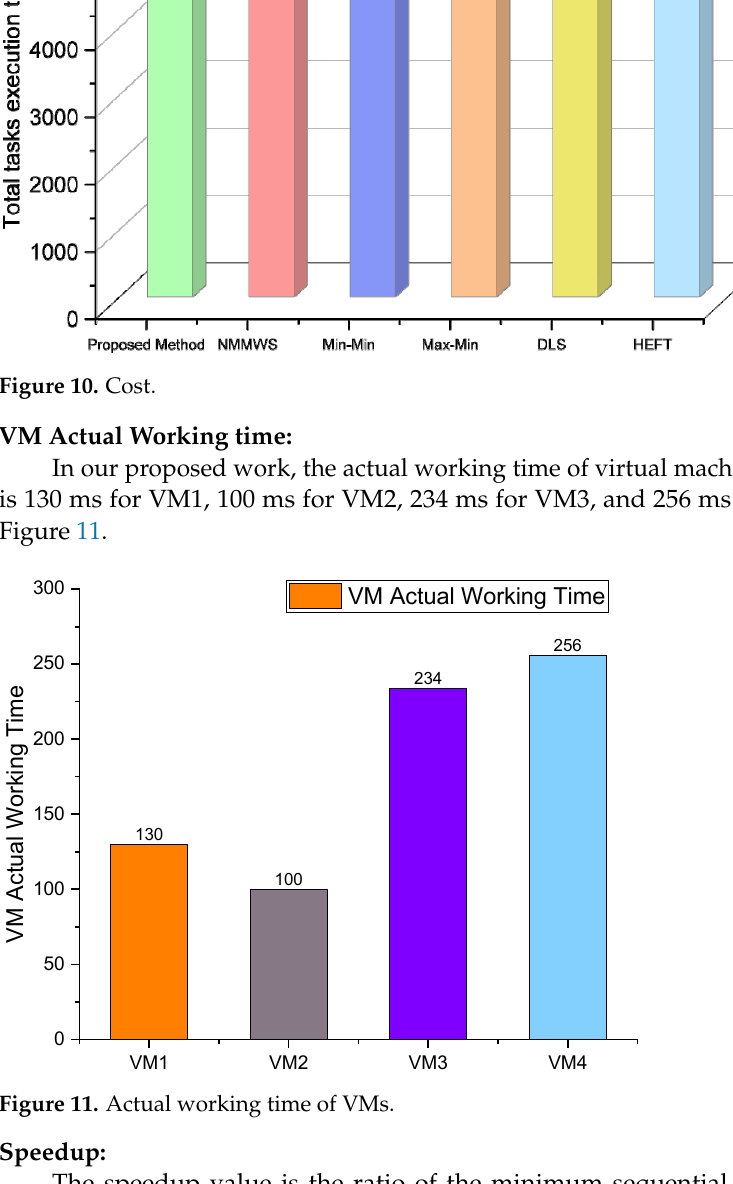
17 of 23 Figure 9. Average cloud utilization.